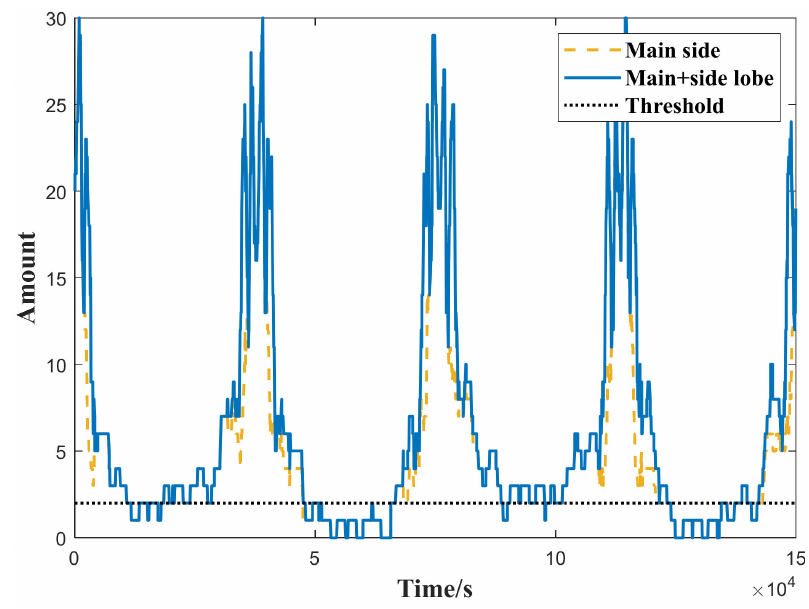
Figure 6. Visibility of GTO satellites to BD satellites when the receiver sensitivity is − 175 dBW.